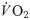
Mean V˙O2 expressed in % of peak
V˙O2 recorded at the end of Part_1 and Part_2 of THREE and TEN.Group means are presented as open circles with standard deviation bars.